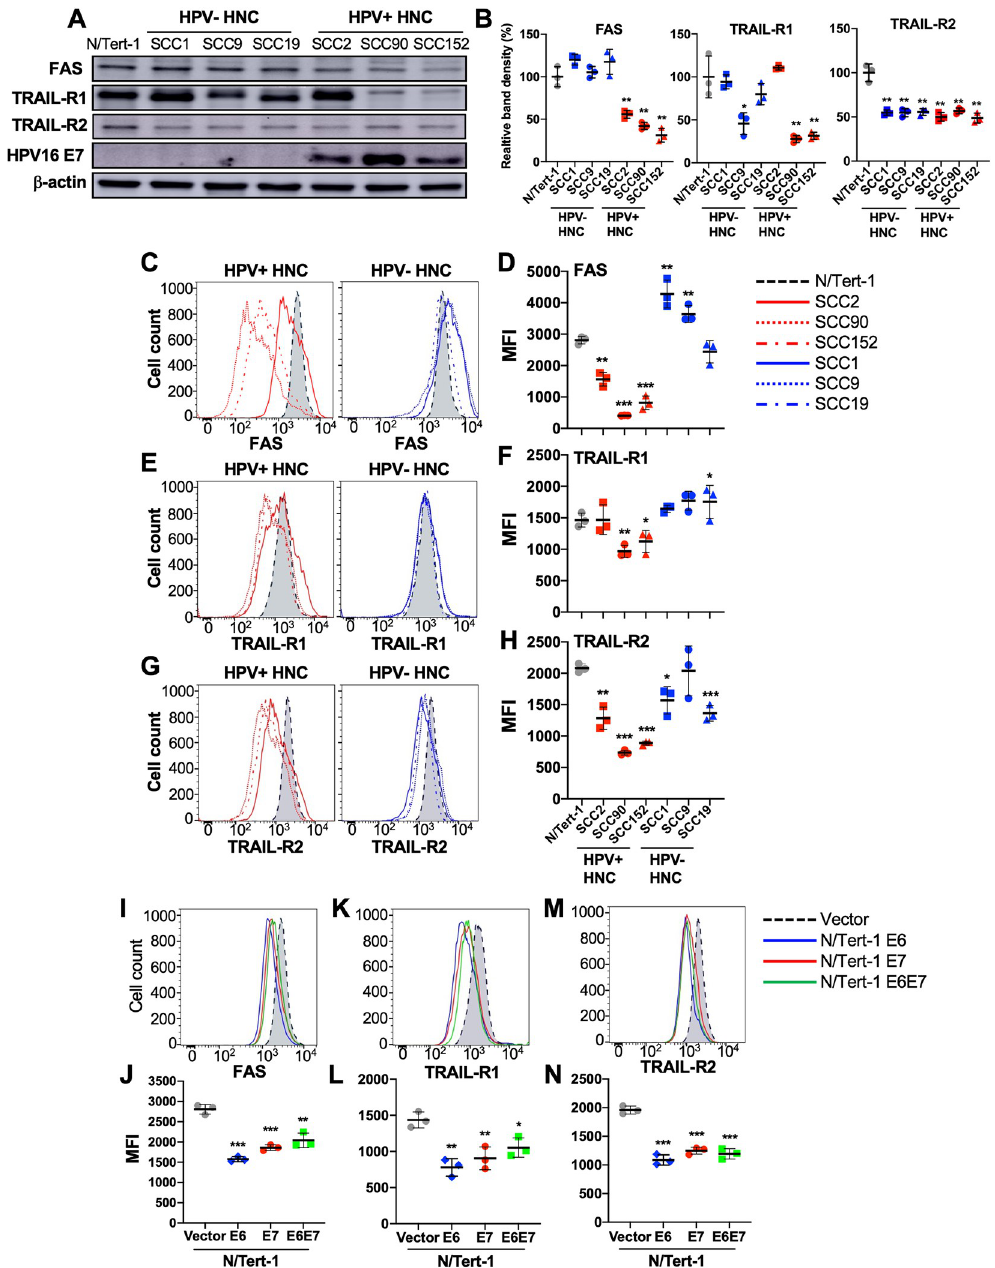
Fig 3. Expression of FAS, TRAIL-R1, and TRAIL-R2 is downregulated in HPV+ HNC cells. Total protein expression of FAS, TRAIL-R1, and TRAIL-R2 in HPV- (SCC1, SCC9, and SCC19) and HPV+ (SCC2, SCC90, and SCC152) HNC cells were determined by western blotting ( A ). Relative band density was quantified using NIH ImageJ ( B ). HPV16 E7 and β - actin were used as viral and internal controls, respectively. Cell surface expression of FAS ( C and D ), TRAIL-R1 ( E and F ), and TRAIL-R2 ( G and H ) proteins on HPV+ (SCC2, SCC90, and SCC152) and HPV- (SCC1, SCC9, and SCC19) HNC cells was analyzed by flow cytometry. Cell surface expression of FAS ( I and J ), TRAIL-R1 ( K and L ), and TRAIL-R2 ( M and N ) proteins on N/Tert-1 cells expressing HPV16 E6, E7, and E6E7 was analyzed by flow cytometry. Mean fluorescence intensities (MFI) of three independent experiments are shown ( D , F , H , J , L , and N ). All experiments were repeated at least three times, and the data shown are means ± SD. P values were determined by Student’s t -test. � p < 0.05, �� p < 0.01, ��� p < 0.001.